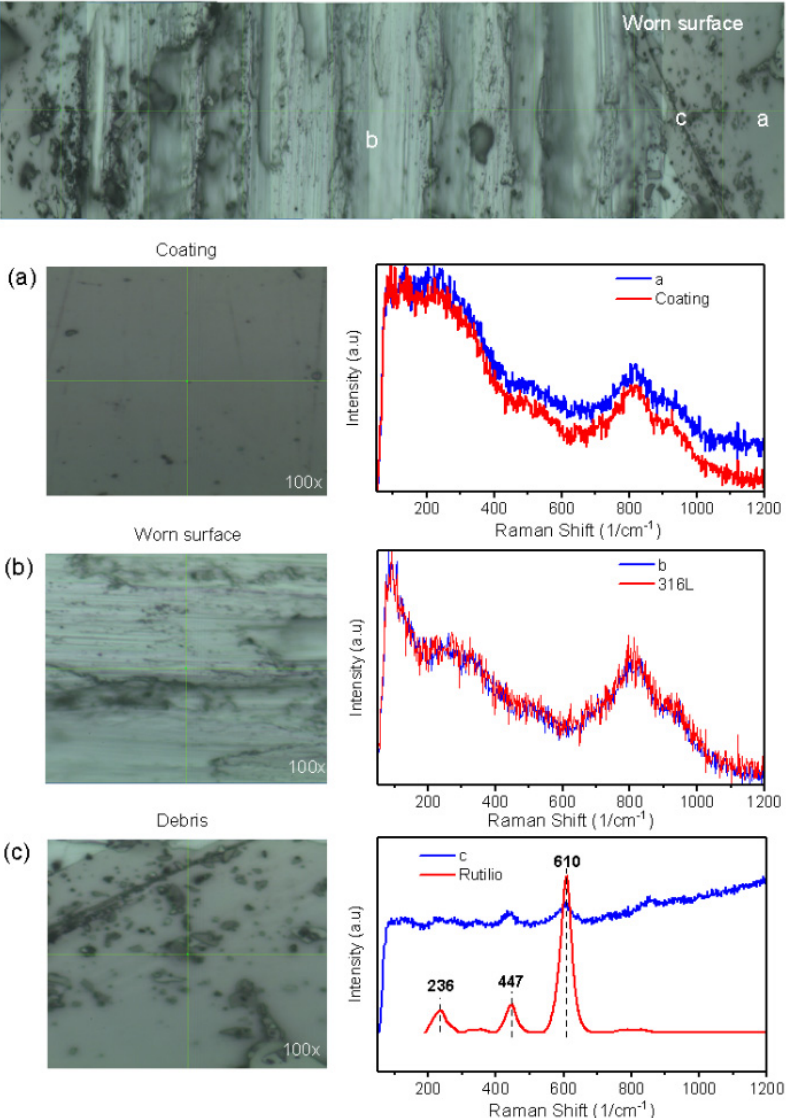
Figure 9. Raman spectroscopy analysis of the wear trace of the TiSi coating. ( a ) Raman spectra of coating; ( b ) Raman spectra of worn surface; ( c ) Raman spectra of debris.